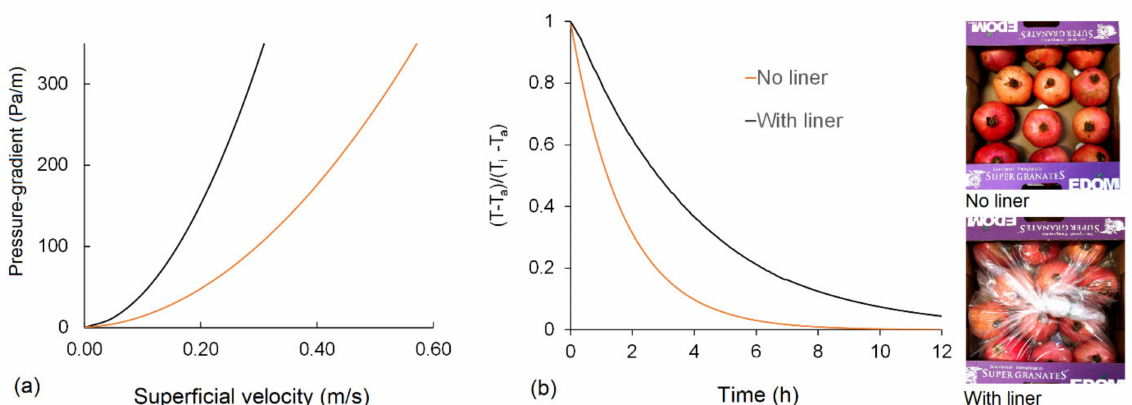
Figure 3. Measuring the effect of internal liner on the airflow resistance ( a ) and the accompanying cooling rate ( b ). Measurements taken for a pallet of packed pomegranate fruit. The packages without liner (No liner) and with liner wrapping (With liner) are shown on the